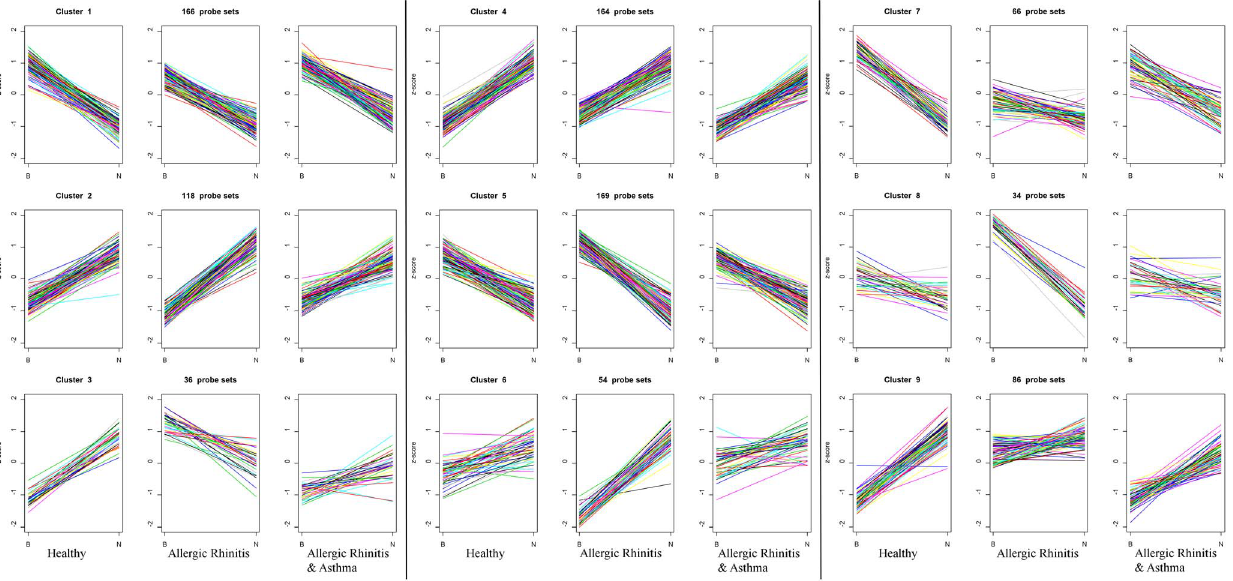
Figure 2. K-means clustering. Every three figures per row represent one cluster. The cluster is mentioned above the first figure. Every first figure are results for healthy subjects; every second figure for patients with rhinitis only; every third figure for patients with both asthma and rhinitis; B = expression level in bronchial epithelium, N = expression level in nasal epithelium.